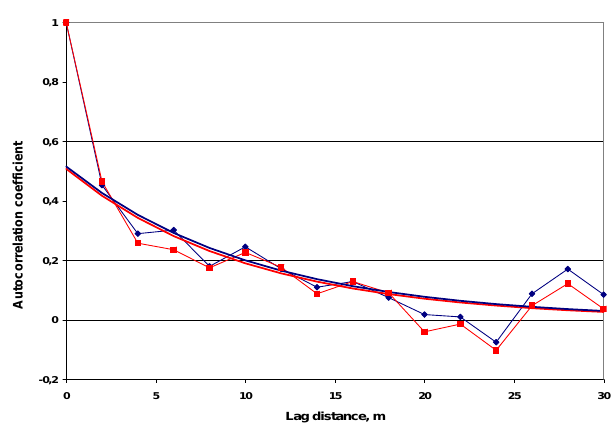
Fig. 5. Estimated autocorrelation coefficients for original data (blue diamonds) and logarithmically transformed zinc values (red squares), shown together with best-fitting negative exponential au- tocorrelation functions for original data (blue curve) and logarithmi- cally transformed data (red curve), respectively. Patterns are similar illustrating that logarithmic transformation of original data does not significantly affect autocorrelation in this application to the Pula- cayo zinc